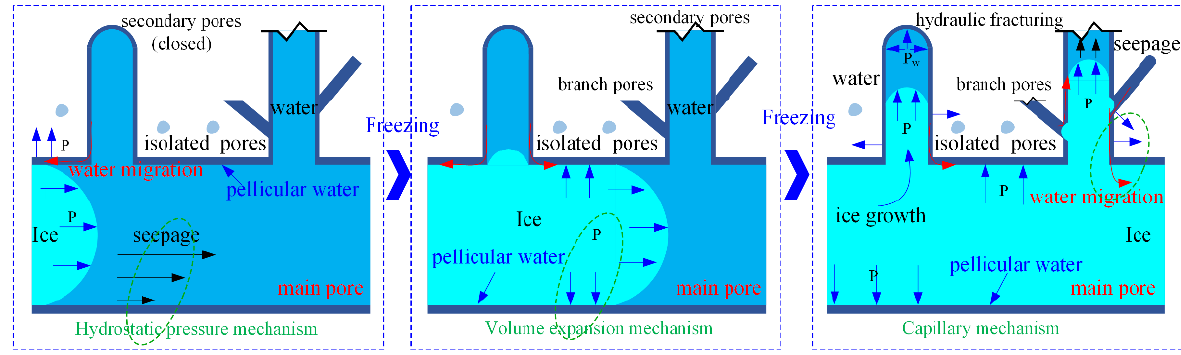
11 of 19 Figure 11. Change in the peak stress and loss rate with F-T action in the tested sandstone. As shown in Figure 12, a schematic diagram of the freezing sequence of the ‘ main- side branch ’ was developed based on the size of the pore structure. The F-T damage in sandstone is the result of a combination of capillary, crystal pressure, hydrostatic, and volumetric expansion mechanisms [13]. When the temperature drops below 0 °C, the main pores initially freeze as ice by heterogeneous nucleation due to their greater curvature [27]. At this time, the ice in the pores drives the unfrozen water to form seepage damage on the pore wall, which is known as the hydrostatic pressure mechanism. The volumetric expansion mechanism, on the other hand, is the damage that is caused by the volumetric expansion of the ice [9]. Since the chemical potential of the water in the small pores is higher than that of the pore ice in the main pores, the supercooled water from the small pores migrates through the pellicular water into the main pores, promoting further development of the structural damage in the pores [27]. The capillary mechanism plays